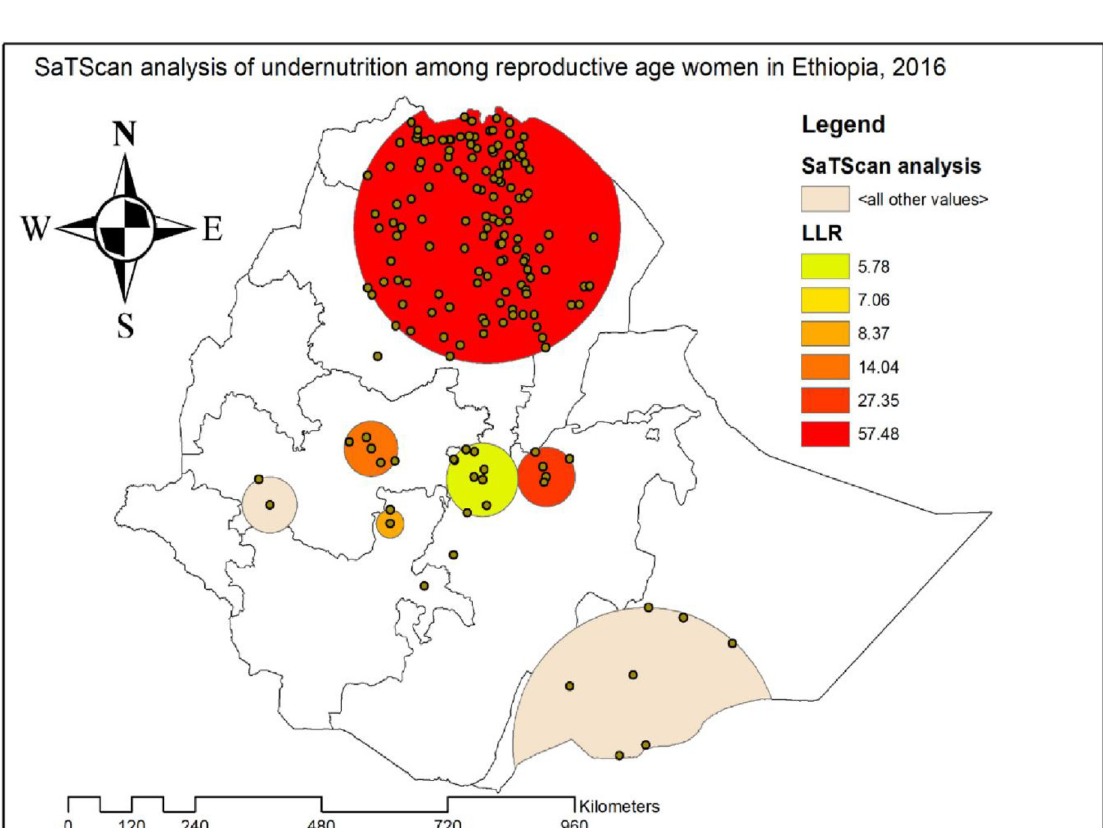
Fig 4. SaTScan analysis of undernutrition among women in Ethiopia, 2016.